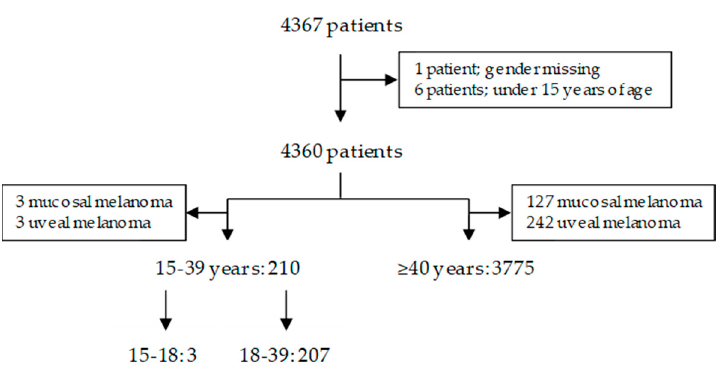
Figure 1. Patient selection for statistical analysis.